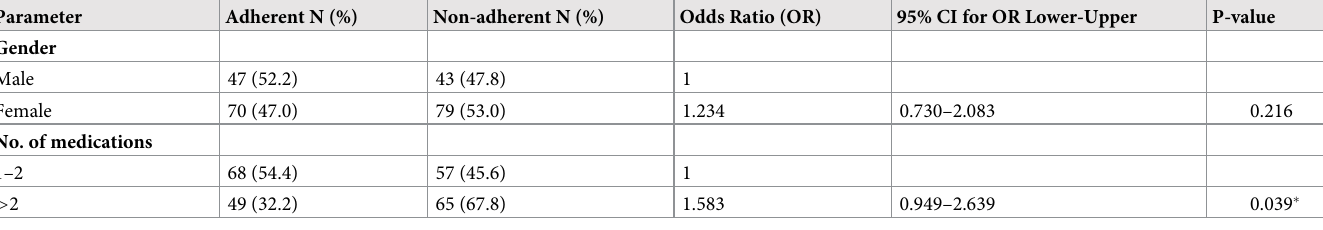
CVD drugs from the KNH patient DBS samples plus quality control DBS samples within each analytical run were within 15% of their baseline concentration and therefore considered stable. The assessment of adherence by determination of the target drug concentration by LC-HRMS analyses of KNH patient DBS samples found that only 117 (70 female:47 male) KNH patients (49.0%) were adherent to their prescribed CVD medications and 122 (79 female:43 male) patients (51.0%) were non-adherent (Table 3). This level of adherence is in line with the 50% figure reported by the WHO for adherence to medications for chronic ill- nesses in developed countries [5]. Table 3. Binary logistic regression analysis identifying factors predicting medication adherence.